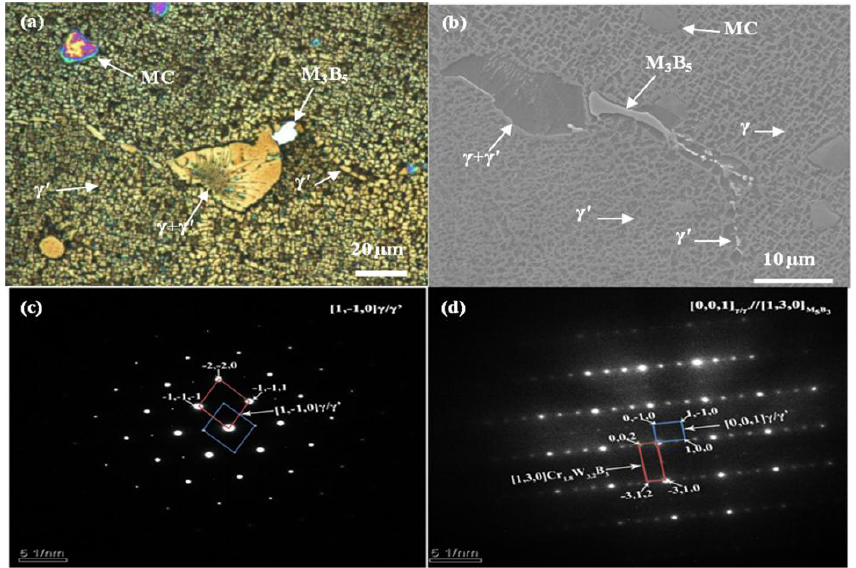
Figure 1. Microstructure of K465 cast superalloy: ( a ) typical phase distribution; ( b ) γ′ phase at grain boundaries and within the grains; ( c ) TEM-SADP of γ 1 phase from r 1,1,0 s zone axis; and ( d ) TEM-SADP of M 5 B 3 from [1,3,0] zone axis.